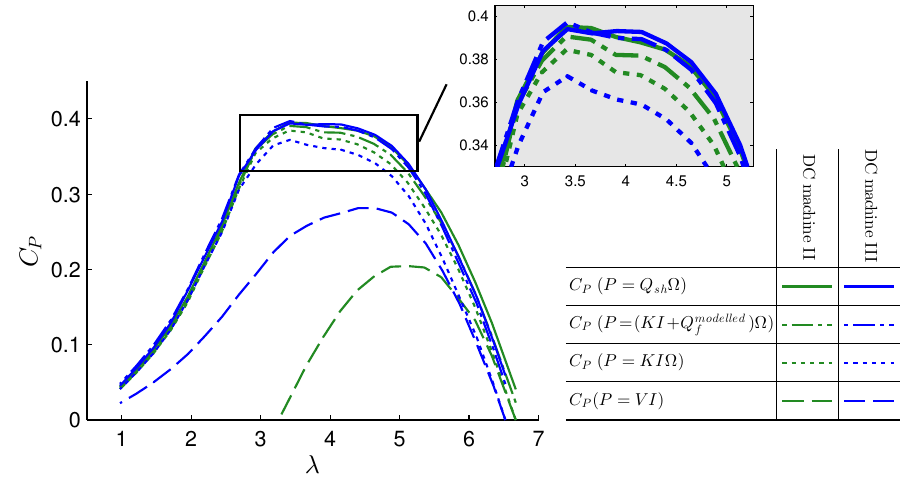
Figure 10. Variation of the power coefficient C P with the tip-speed ratio λ for the miniature turbine with two different DC machines under the same inflow conditions. For each DC machine, the turbine power is calculated with different methods. The free-stream incoming velocity is equal to 8 ms − 1 .